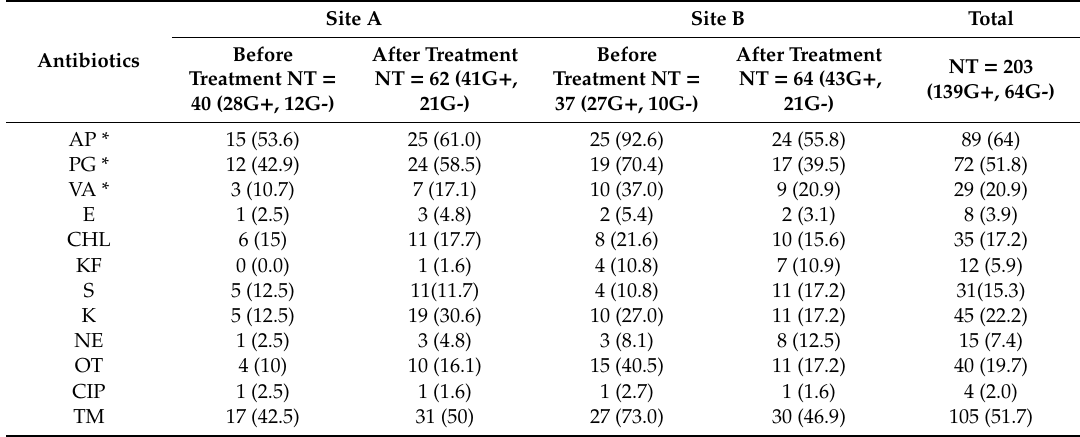
Table 3. Number and percentage of heterotrophic bacterial isolates resistant to the